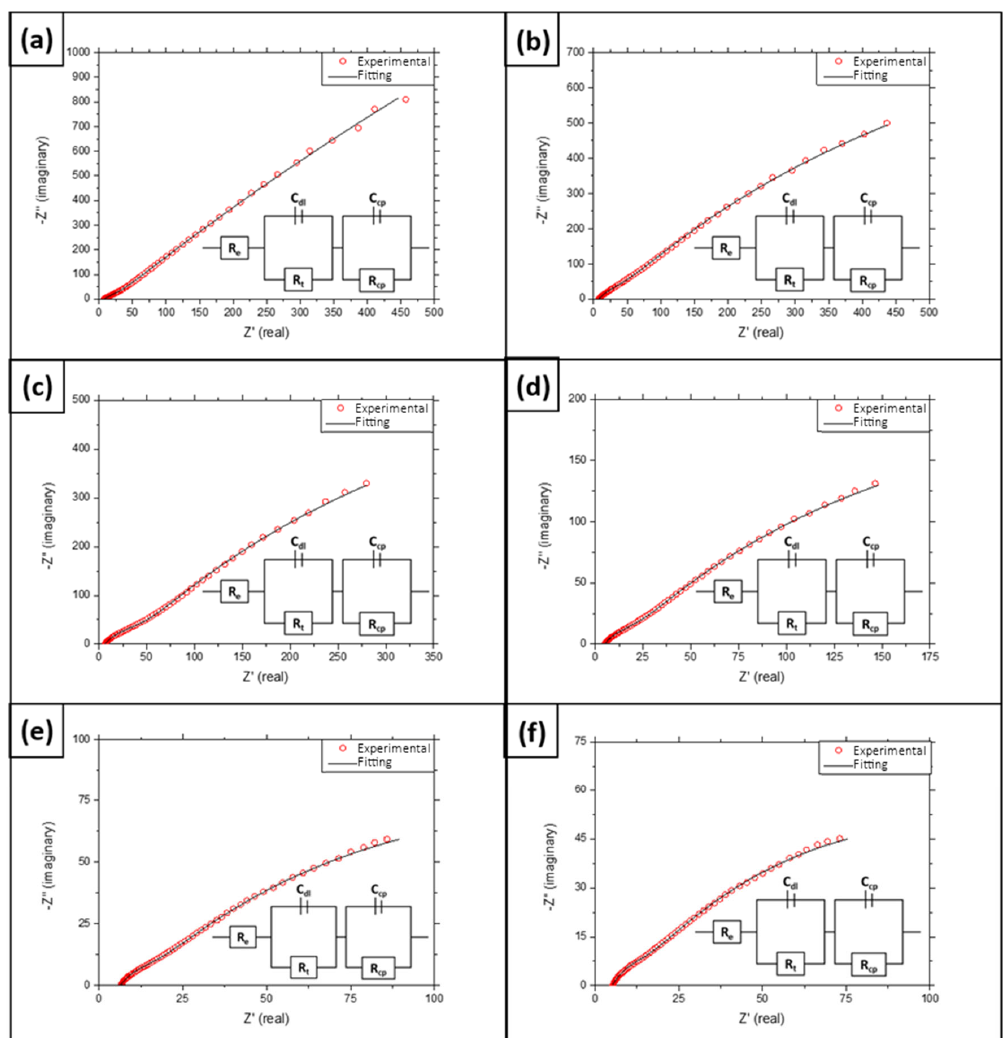
Figure 3. Impedance spectra of the coated P91 samples tested at 500 °C in Solar Salt at ( a ) 24 h; ( b ) 72 h; ( c ) 500 h; ( d ) 1000 h; ( e ) 1500 h; and ( f ) 2000 h.